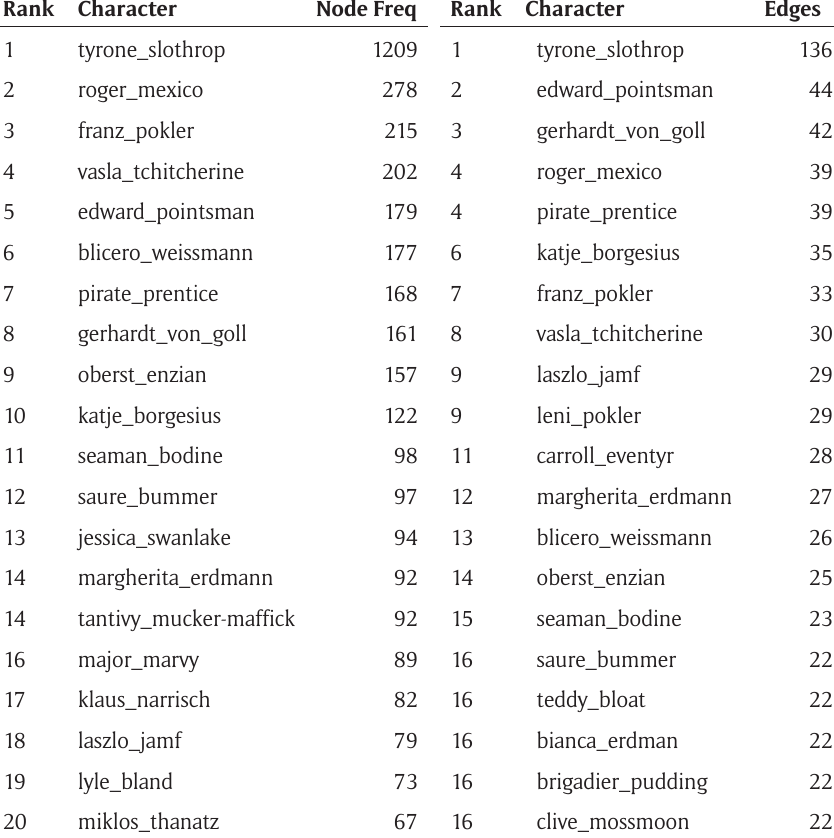
Table 2: Gravity’s Rainbow: Complete Network Node Frequency and